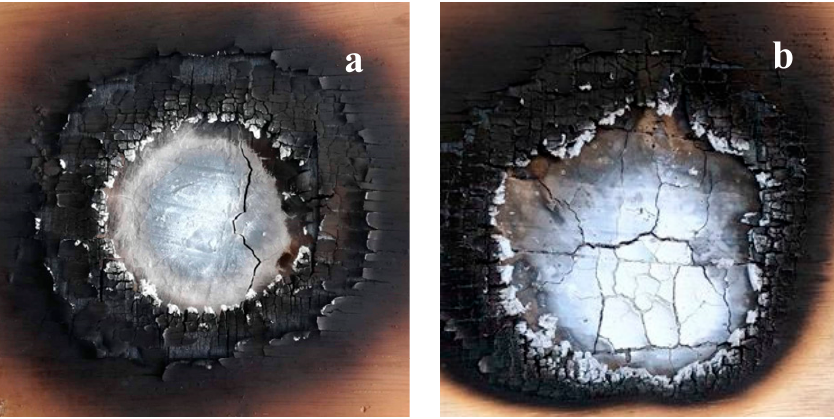
Figure 13. Fire door prototypes ( a ) P2 and ( b ) commercial after the 2-h fire test.